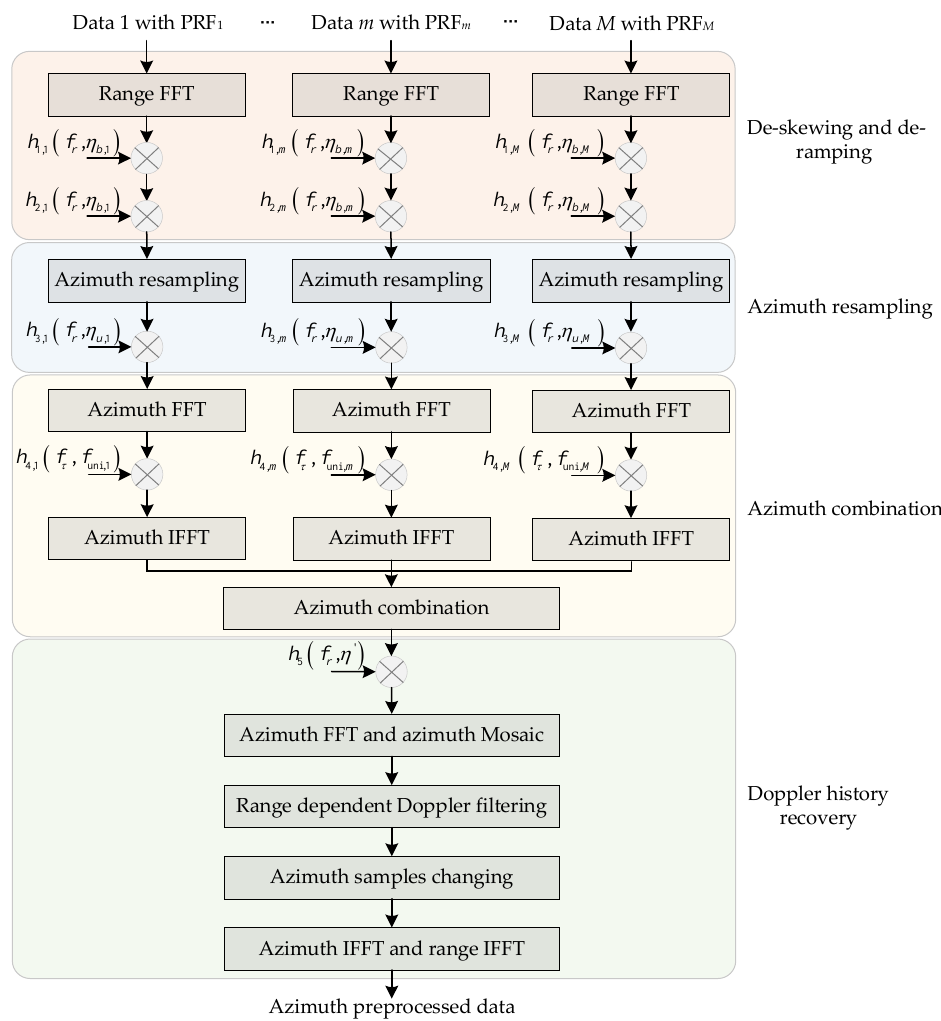
Figure 13. The block diagram of 2-D azimuth pre-processing of the proposed method.